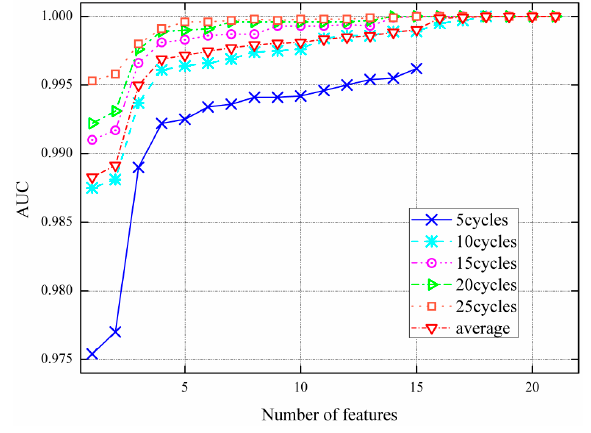
Figure 6. AUC for the rotor angles feature subset.